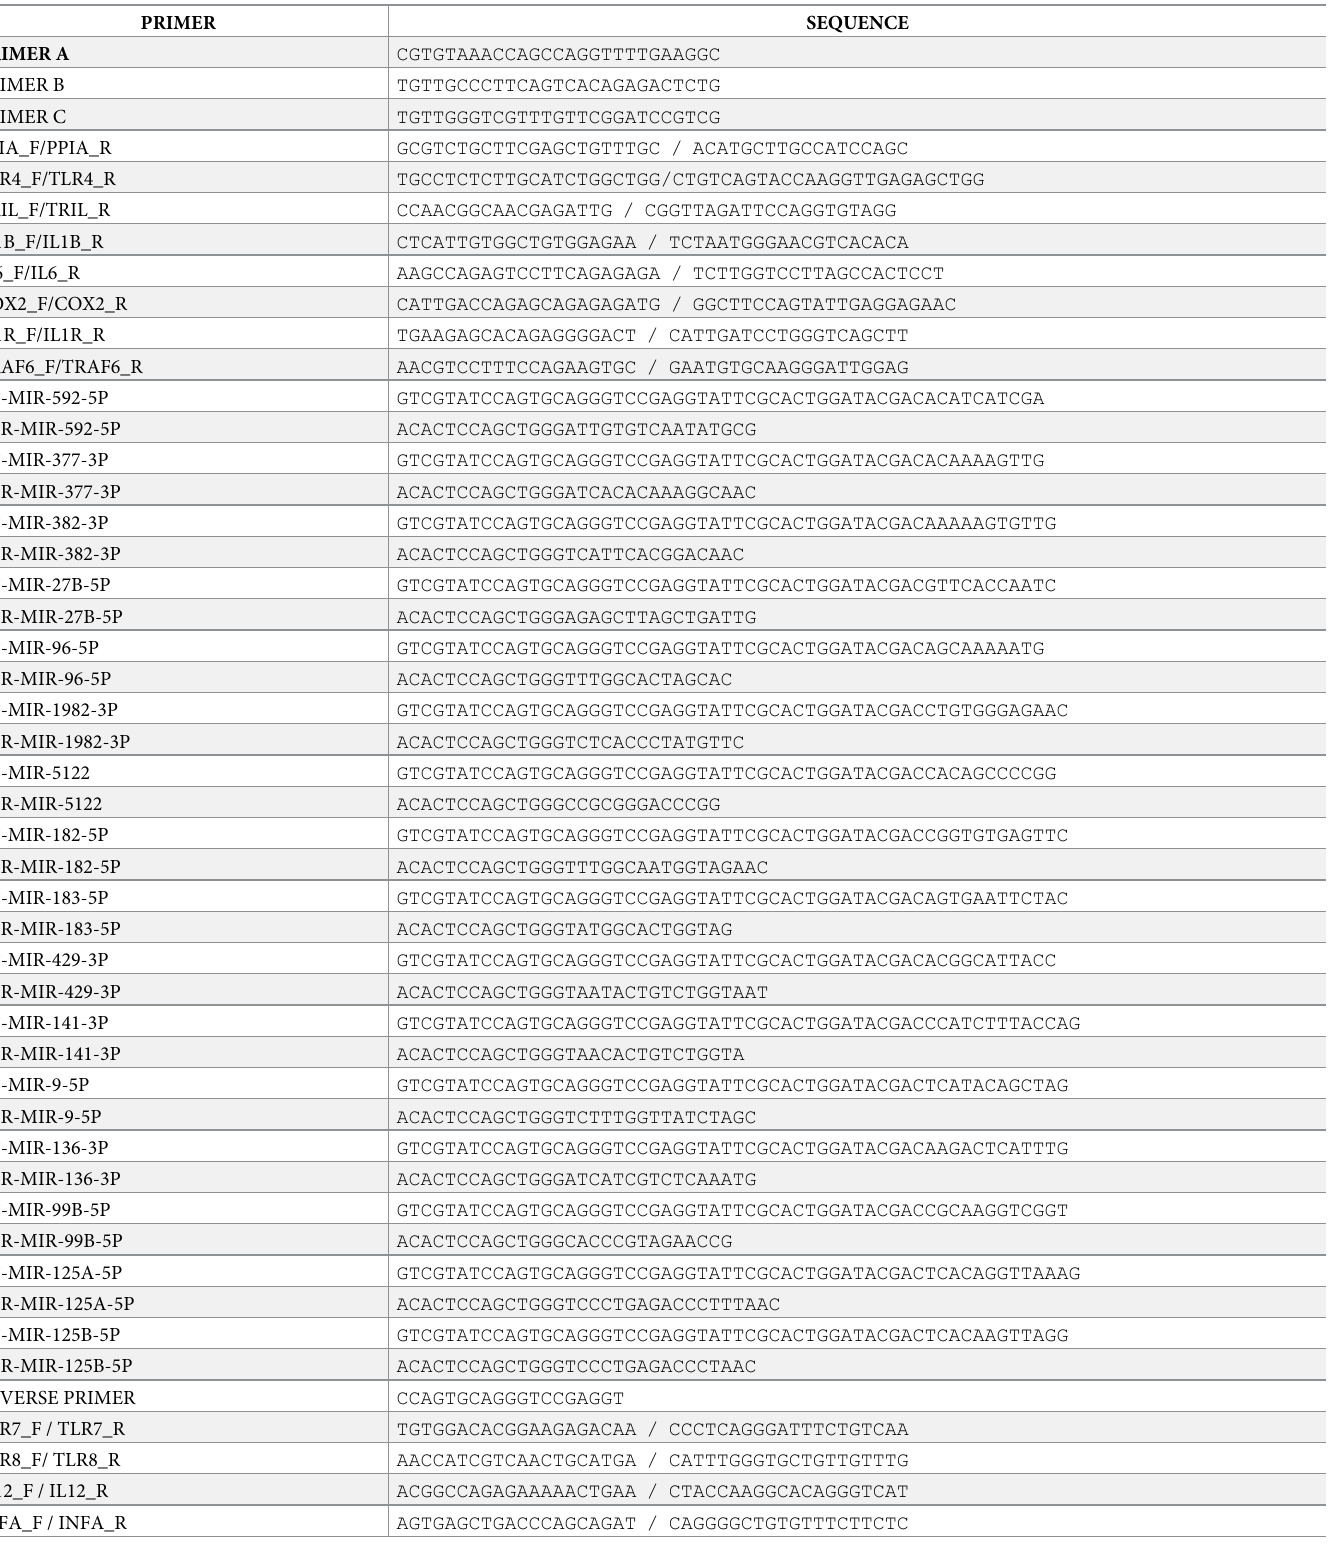
Table 1. The RT and RT-qPCR primers